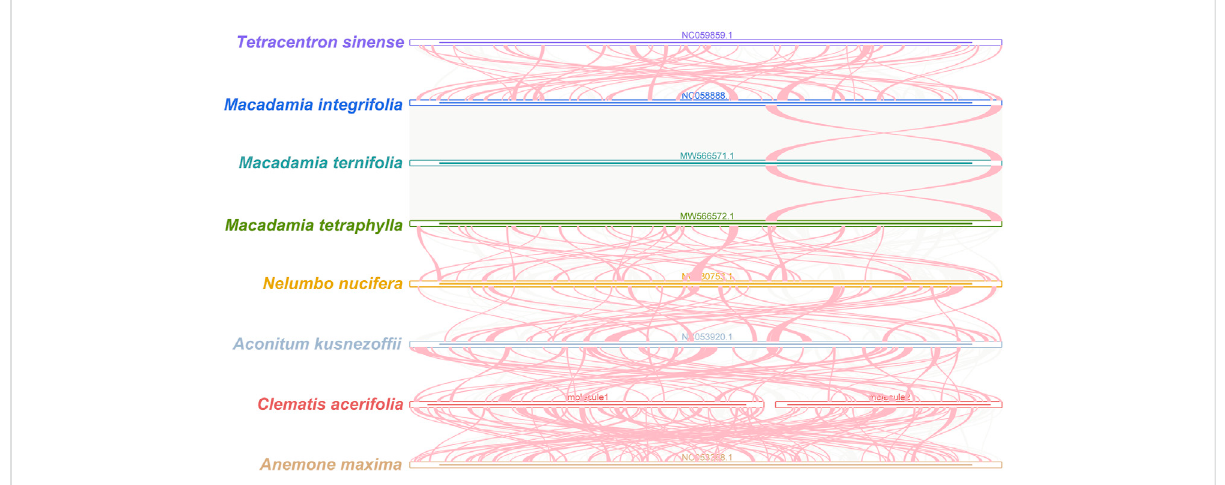
FIGURE 8 C.acerifolia mitogenomesynteny.Barsindicatedthemitogenomes,andtheribbonsshowedthehomologoussequencesbetweentheadjacent species. The red areas indicate where the inversion occurred, the gray areas indicate regions of good homology. Common blocks less than 0.5 kb in length are not retained, and regions that fail to have a common block indicate thatthey are unique to the